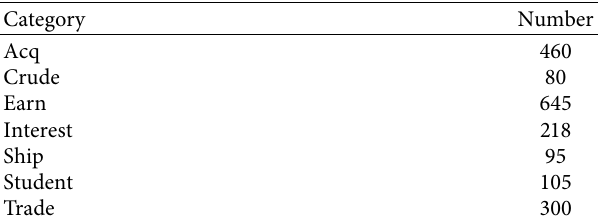
Table 3: The number of English unbalanced